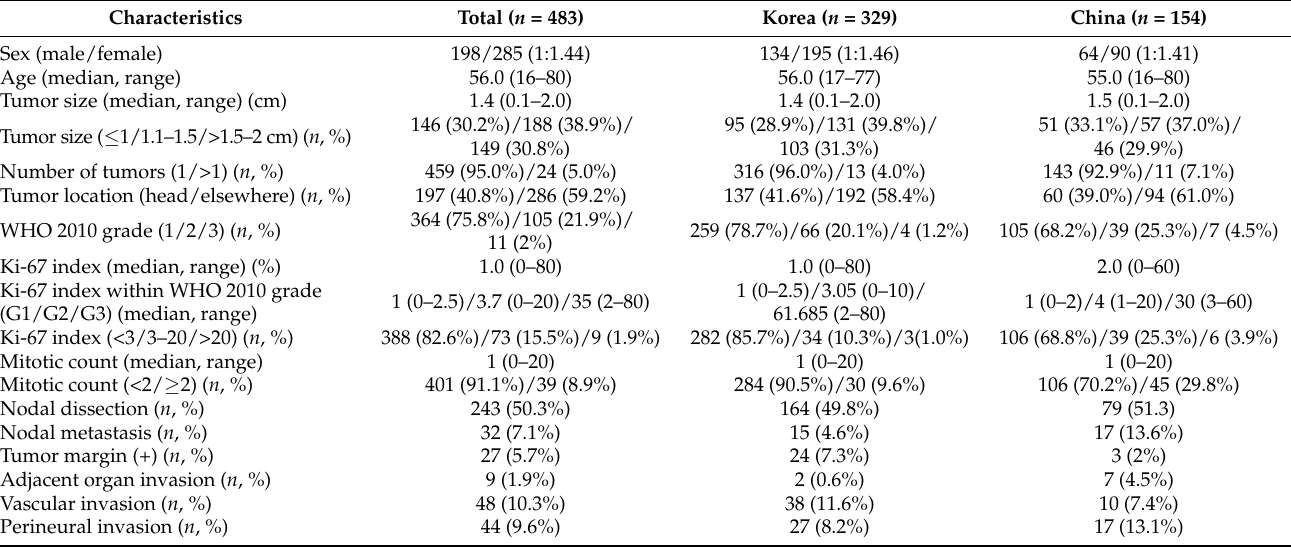
Table 1. Clinical characteristics of the patients.